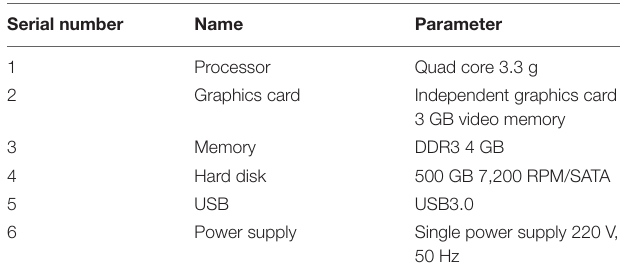
TABLE 1 | Parameters of PC used in the